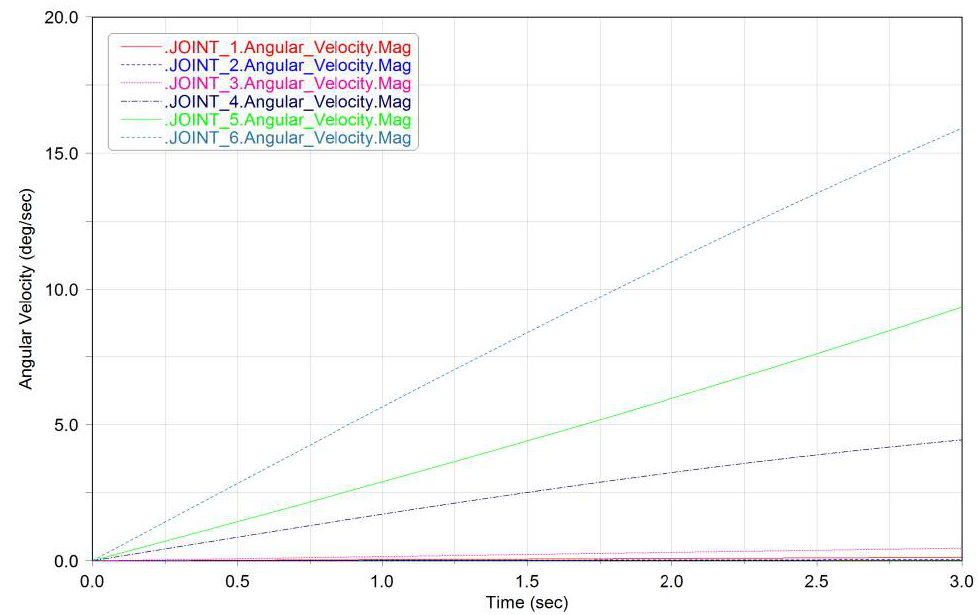
Figure 7. The angular velocity of each joint over time (ADAMS).